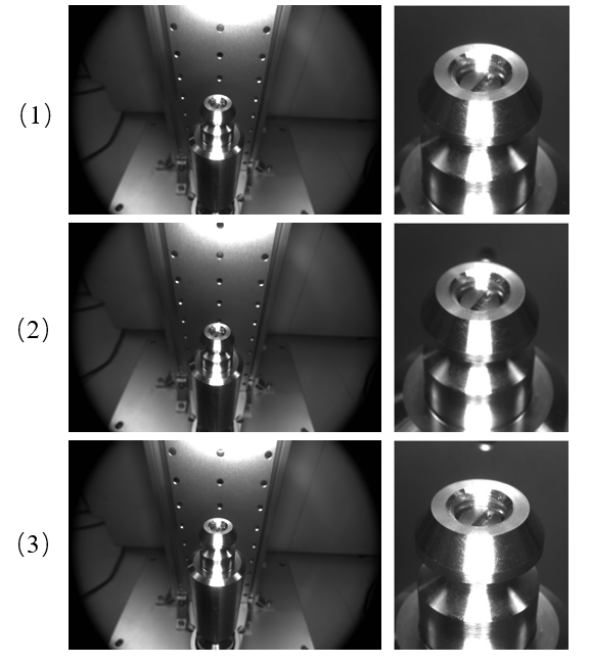
Figure 6. Template-matching effect. The left is the original image, and the right is the matching